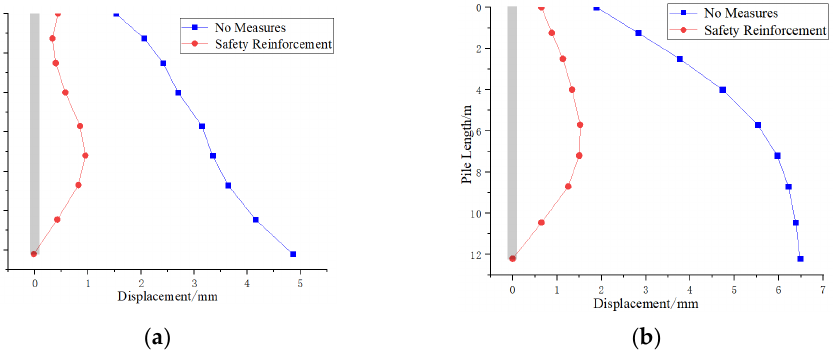
Figure 16. Comparison curve of safety reinforcement of end-suspended pile: ( a ) pile Z2; ( b ) pile Z3.